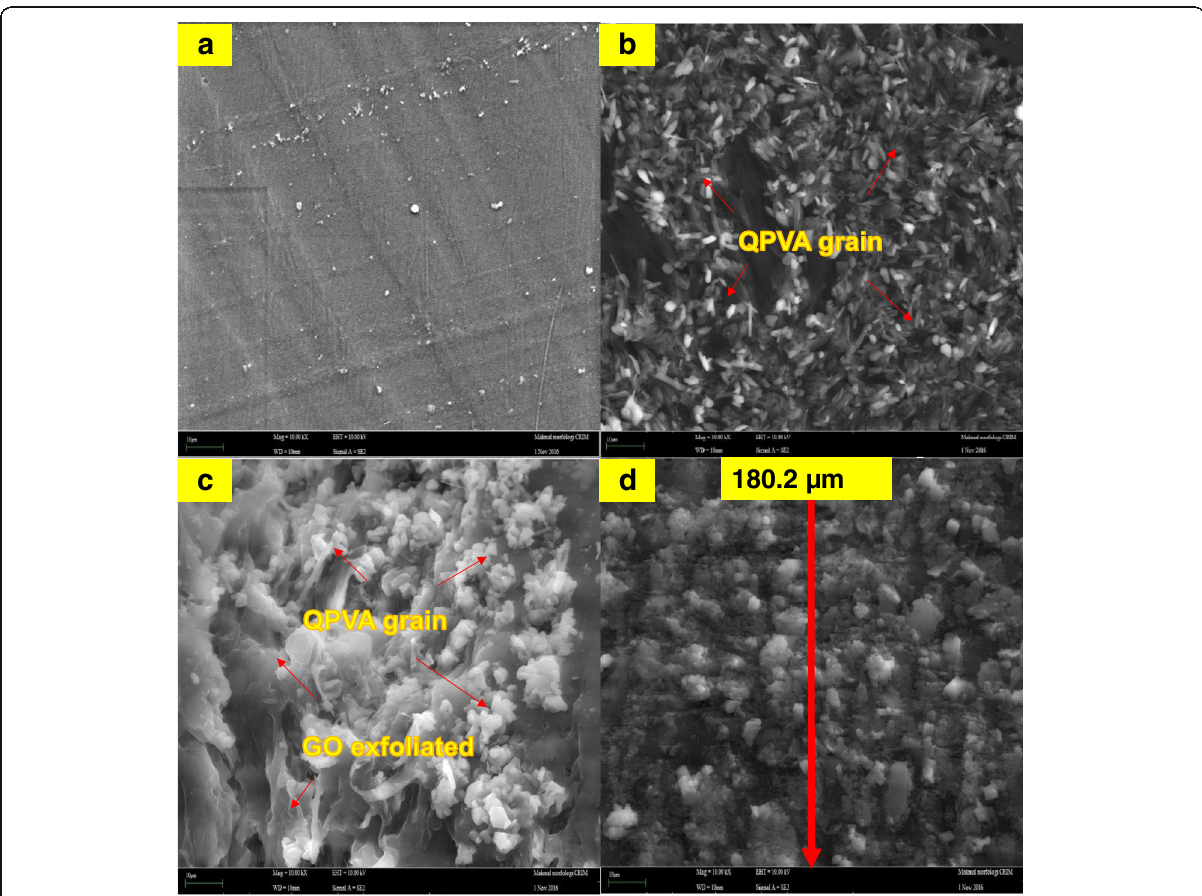
Fig. 6 FESEM image of a surface PVA membrane, b surface QPVA membrane, c surface of QPVA/GO composite membrane, and d cross section of QPVA/GO composite membrane